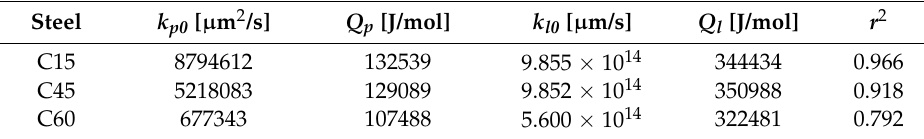
Table 8. Model coefficients for the Arrhenius approach for investigated